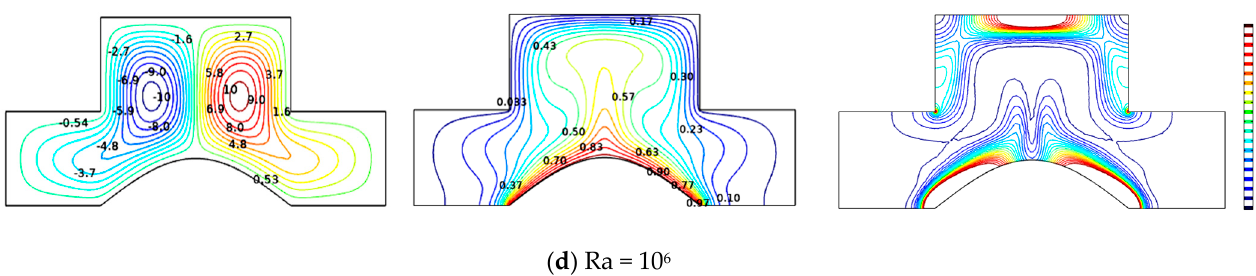
Figure 4. Variations of the streamlines ( left ), isotherms ( middle ), and general entropy ( right ) with various values of Rayleigh number (Ra),solid volume fraction ( 𝜙) = 0.02, Ha = 0, Da = 0.01, nanoparticle volume fraction ( 𝜙 ) = 0.02, and porosity ( 𝜀 (cid:3043) ) = 0.4. In Figures 5–10, the values of Nu calculated on the hot wall, Nusselt average, and total entropy are displayed for different values of Ra, Ha, Da, 𝜙 , and 𝜀 (cid:3043) .